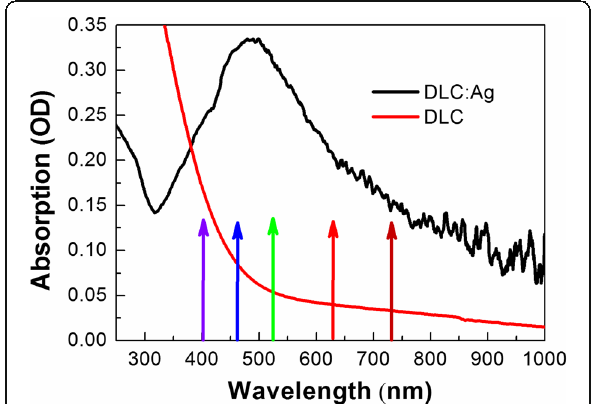
Fig. 2 Steady-state absorption spectra of DLC:Ag nanocomposite film deposited on the fused silica substrate. The arrows at 407, 470, 528, 627, and 736 nm indicate excitation wavelengths used in the TAS spectroscopy and photoelectrical